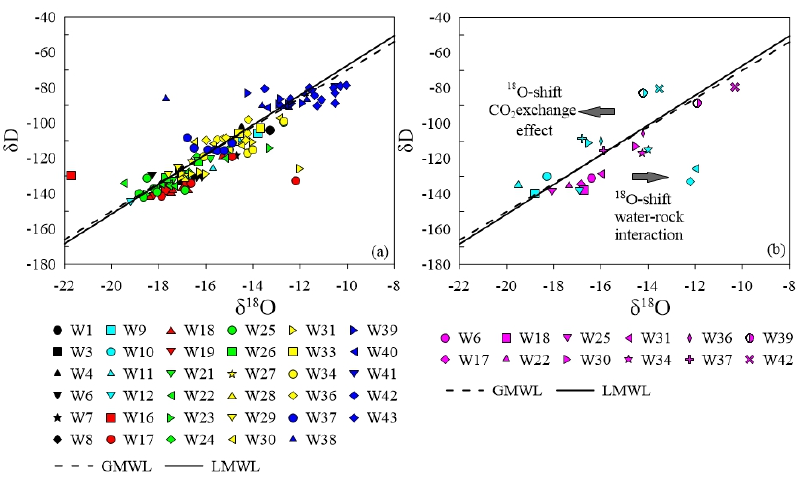
Figure 2. Stable oxygen and hydrogen isotope of the 43 hot springs and their correlations with GMWL and LMWL. LMWL: δ D = 8.41 δ 18 O + 16.72 [33]. ( a ) Hydrogen and oxygen isotope distribution of all hot spring sites in the study area. ( b ) The distribution of hydrogen and oxygen isotopes at the hot spring sites that were measured after the 12 May 2008 Wenchaun M S 8.0 and 20 April 2013 Lushan M S 7.0, respectively. The rosy symbol represented samples collected after the 20 April 2013 WenchaunM S 8.0 and the sky-blue symbol stands for samples collected after the 20 April 2013 Lushan M S 7.0.